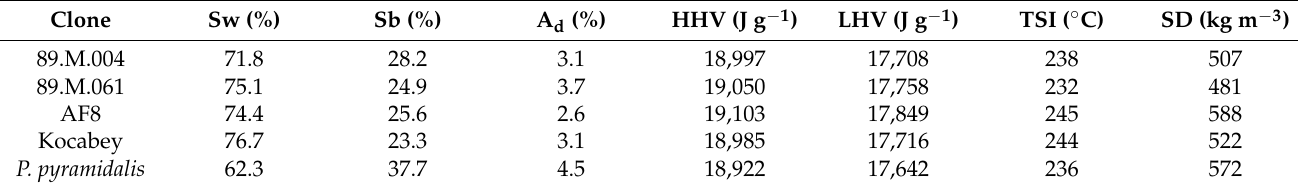
Figure 2. Mean values ± standard error (vertical bar) for: ( a ) diameter at breast height (DBH (mm)), ( b ) height (H (cm)), ( c ) dry matter yield per unit area (DM (Mg ha − 1 )), ( d ) mean annual increment of dry matter yield (MAI (Mg ha − 1 yr − 1 )) for clones. The values expressed per unit area were calculated, taking survival rate into account. The same letters indicate statistically homogenous groups of clones at p < 0.05 in the LSD test. Table 4. Weighted mean values of the stem parameters for the tested